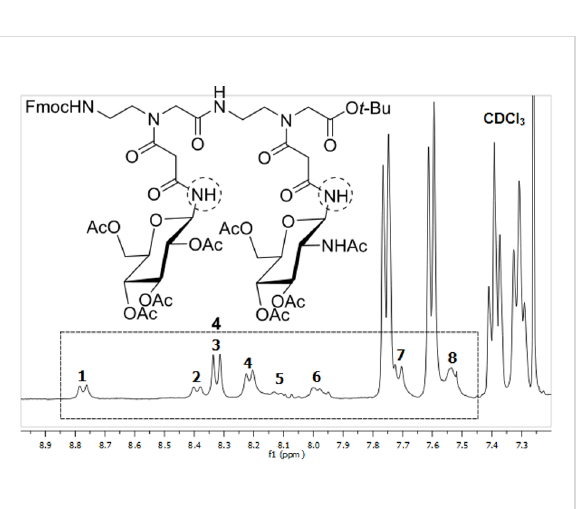
Figure 5: 1 H NMR (400 MHz) of building block 1b in CDCl 3 . The amide signals of the rotamers are marked.